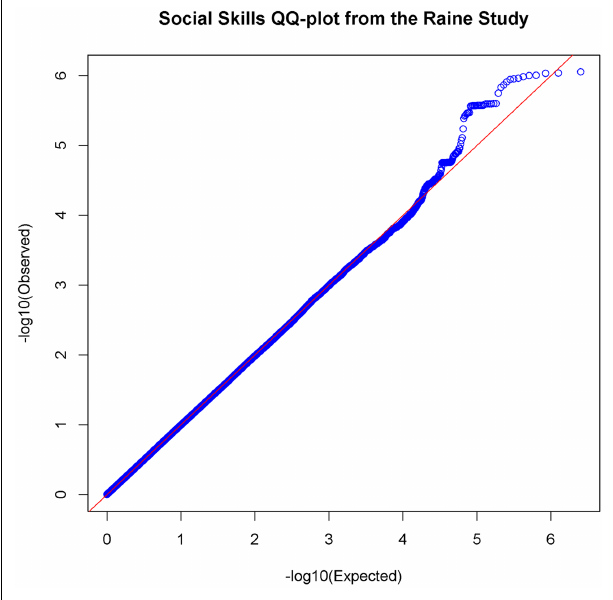
FIGURE 2 | Quantile–Quantile Plot of association results for social skills . Q–Q plots compare the observed p- values [ − log10(Observed)] to expected p- values. [ − log10(Expected)] on the logarithmic scale under the null hypothesis of no significant